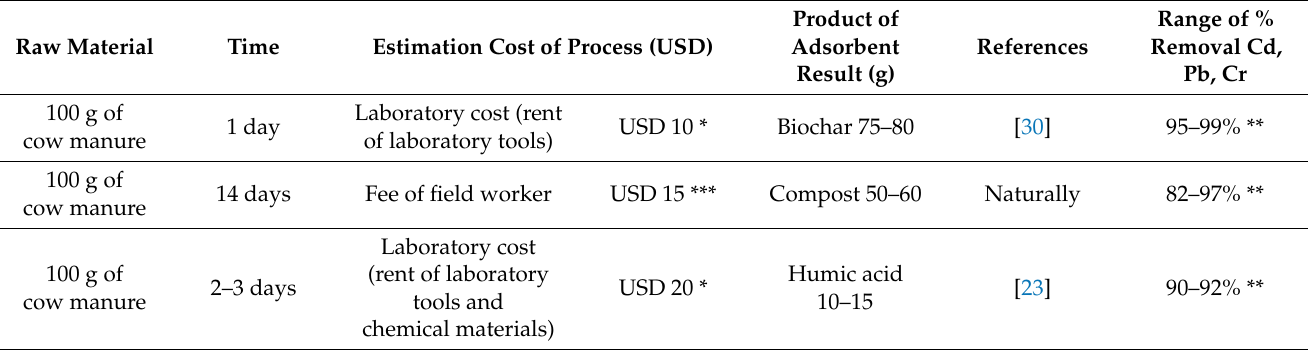
Table 4. Analysis factors to produce adsorbent